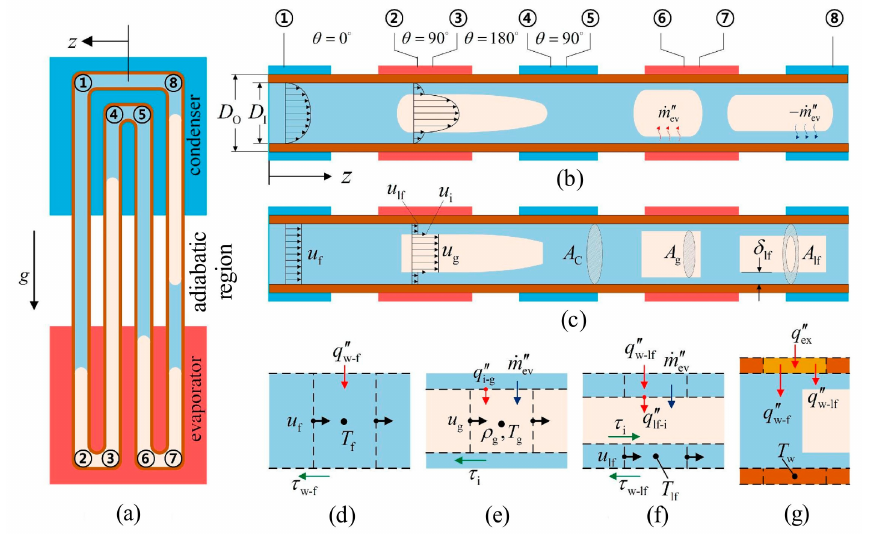
Figure 7. Schematics of vertical heat pipe and control volume analysis [134]. Bae et al., (2017). ( a ) Schematic. ( b ) Plug flow on z-axis. ( c ) One-dimensional plug flow. ( d ) Liquid slug. ( e ) Vapor plug. ( f ) Liquid film. ( g )